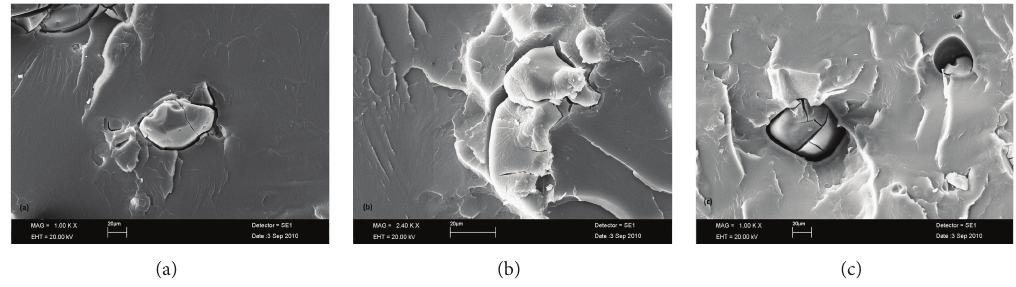
Figure 4: SEM image. (a) PMMA-L-1; (b) PMMA-L-2; (c) PMMA-L-3.